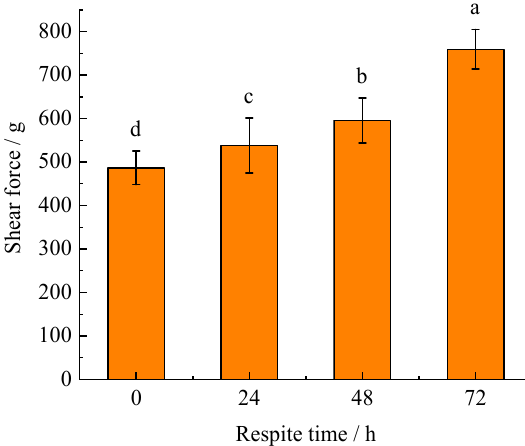
Figure 2. The effect of respite time before live transportation on shear force of blunt snout bream. Different lowercase letters indicate significant difference ( p < 0.05).